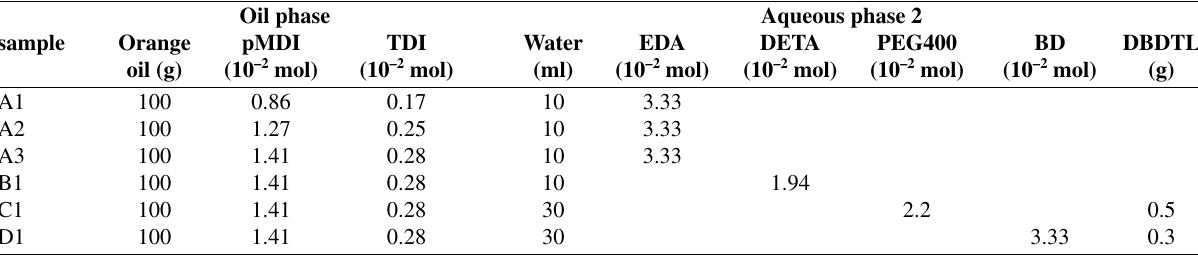
Table 1. Composition of the oil phase and aqueous phase 2 of the emulsion Oil phase Aqueous phase 2 sample Orange pMDI